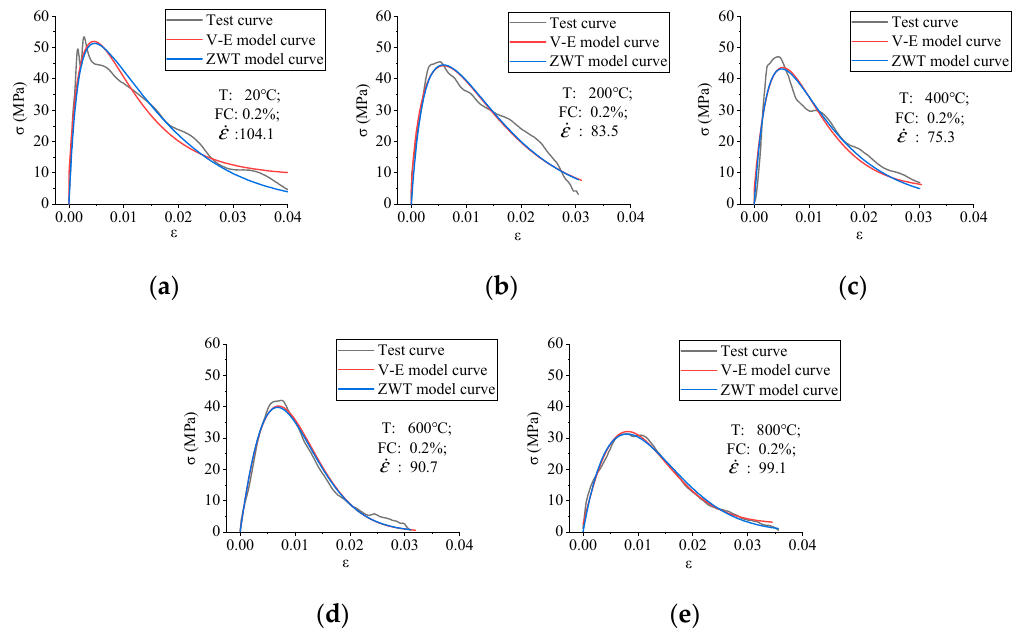
Figure 11. The comparison between test curves and fitting curves at different temperatures (fiber contents: 0.2%, impact velocity: 8.8 m/s). ( a ) Temperature: 20 °C; ( b ) temperature: 200 °C; ( c ) temperature: 400 °C; ( d ) temperature: 600 °C; ( e ) and temperature: 800 °C.